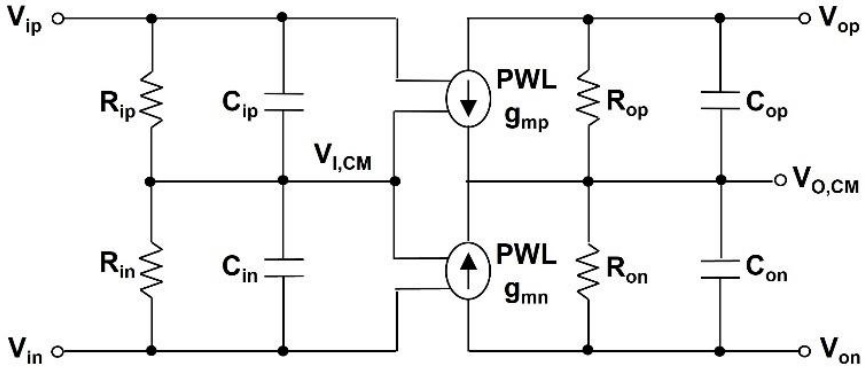
Figure 3. Amplifier macro model.